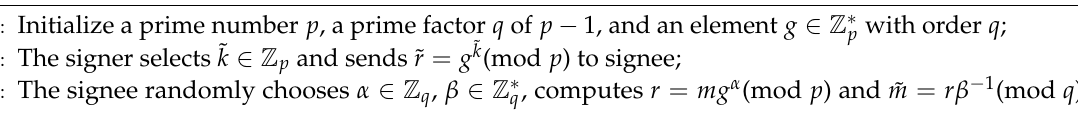
Algorithm 2 Blind Nyberg-Rueppel Signature